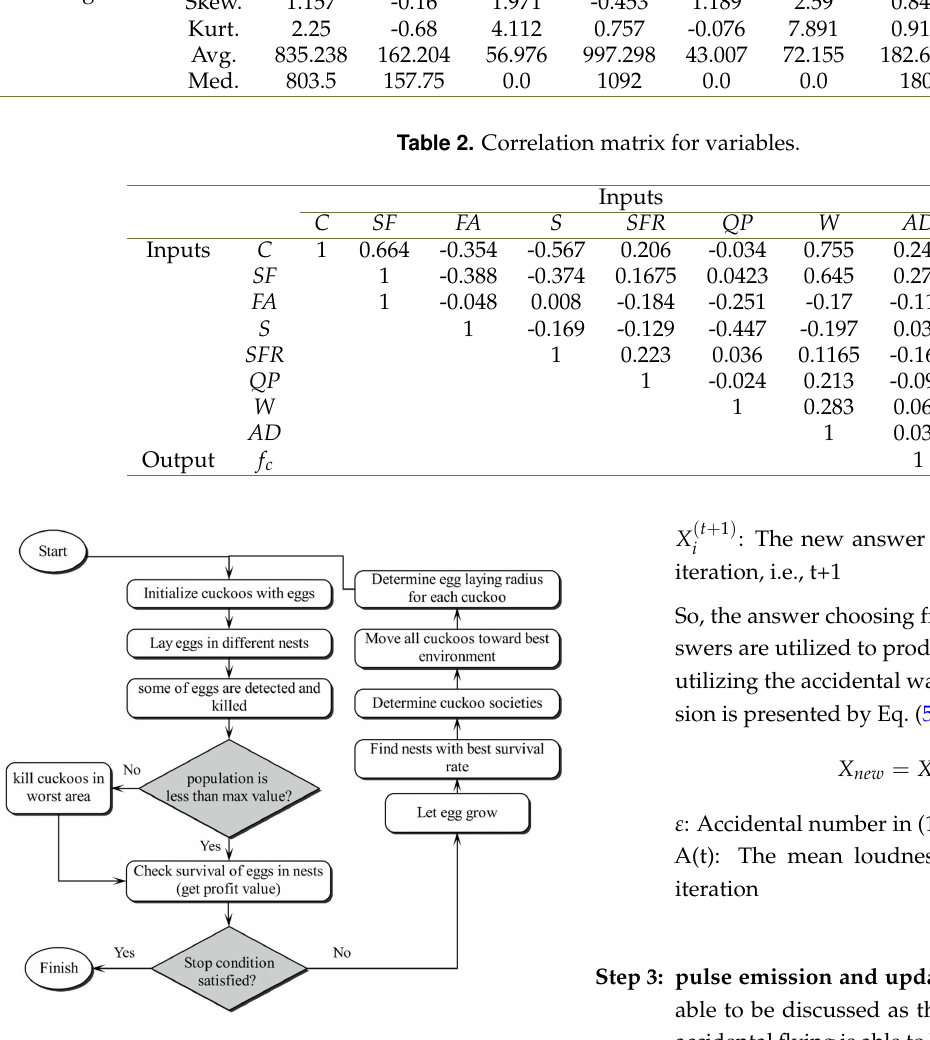
Fig. 2. Flowchart of COA